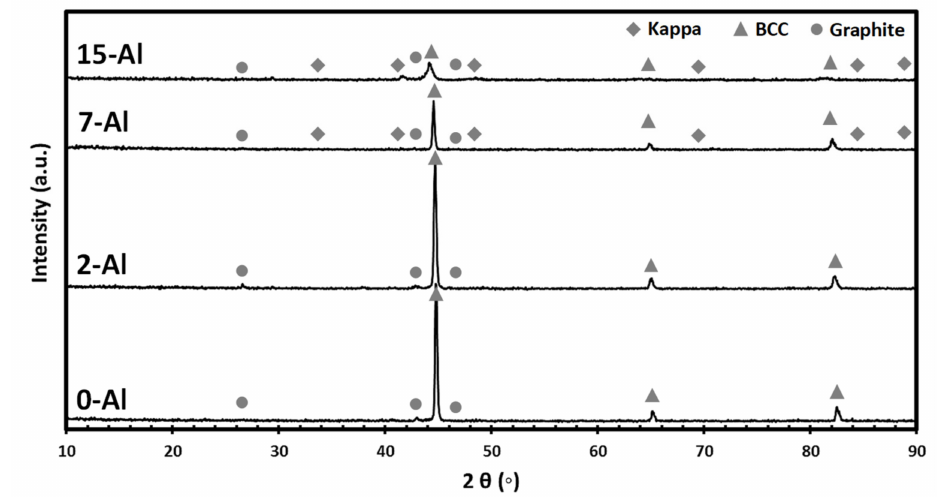
Figure 2. X-ray diffraction (XRD) patterns of the developed cast